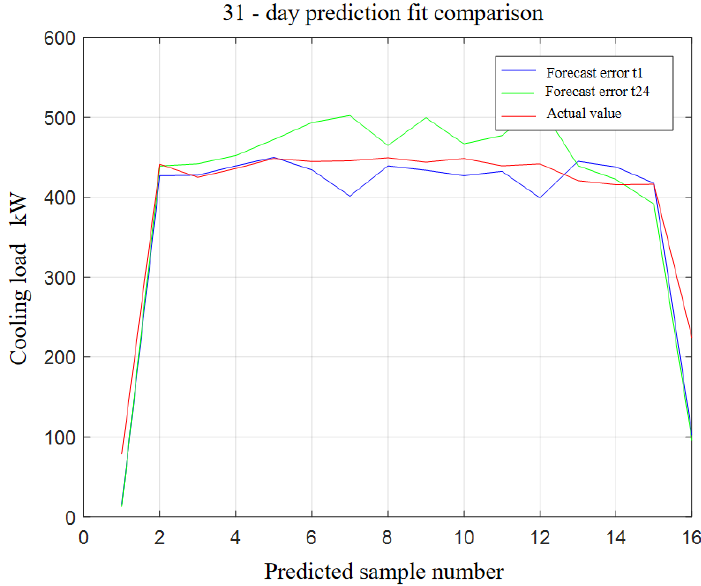
Figure 44. The comparison chart of prediction fitting.